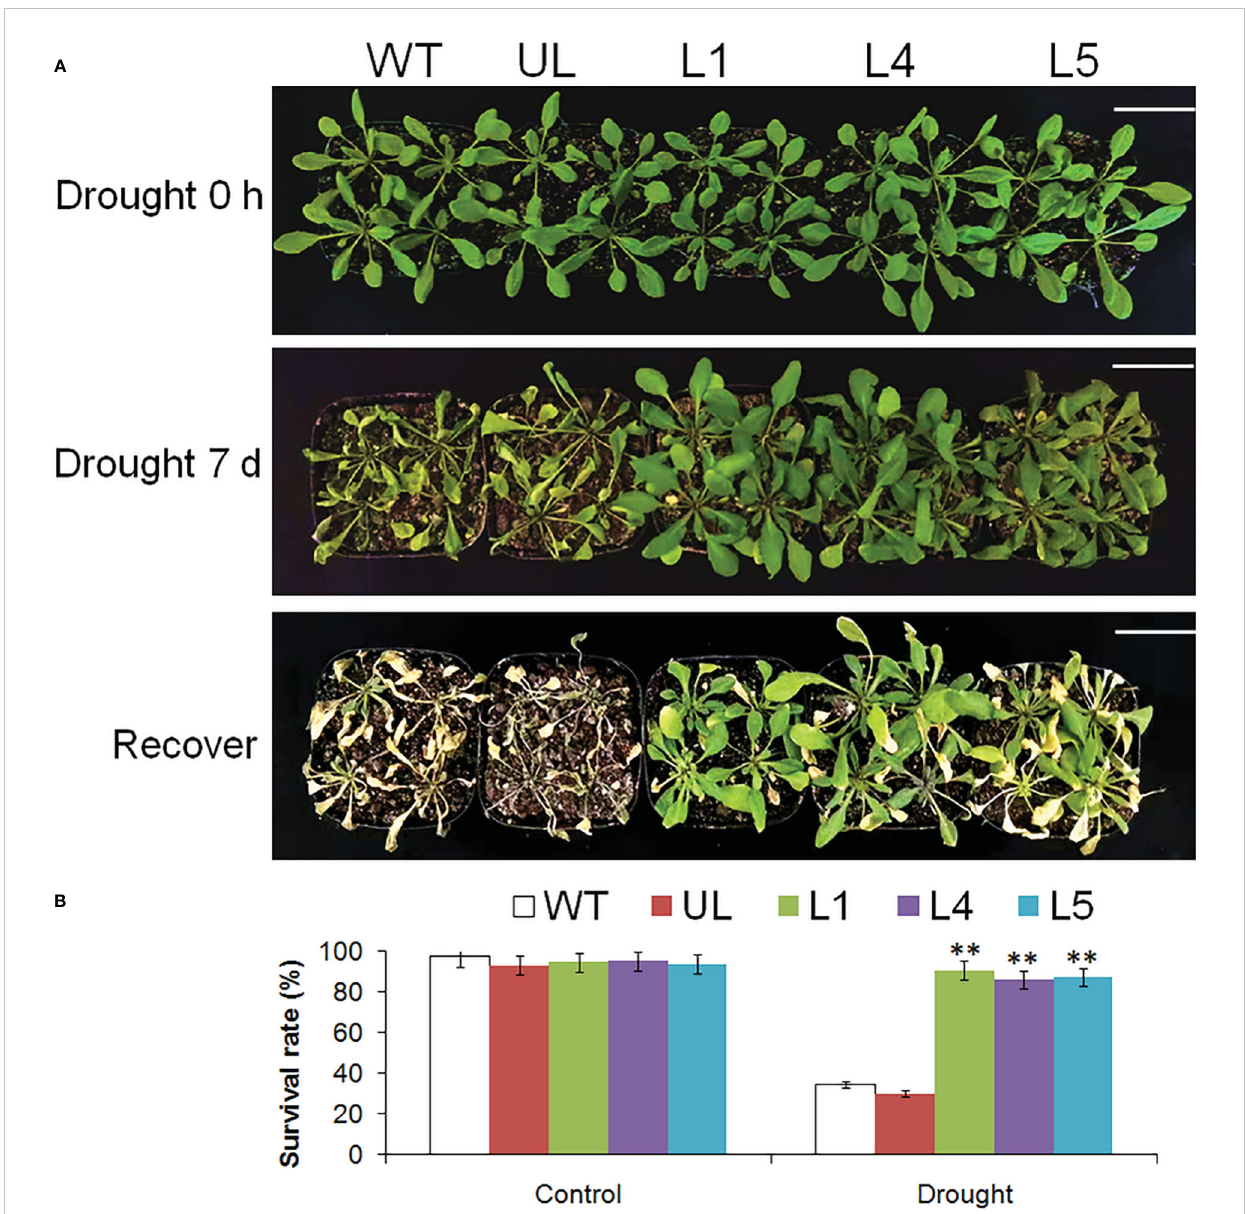
FIGURE 8 Phenotype and survival rate of A. thaliana . (A) The phenotypes of WT, UL, L1/4/5 lines were observed after 0 and 7 d of stopping watering and recovering growth. (B) The survival rate of A. thaliana under control and drought stress. Bar= 5 cm. (**, p ≤